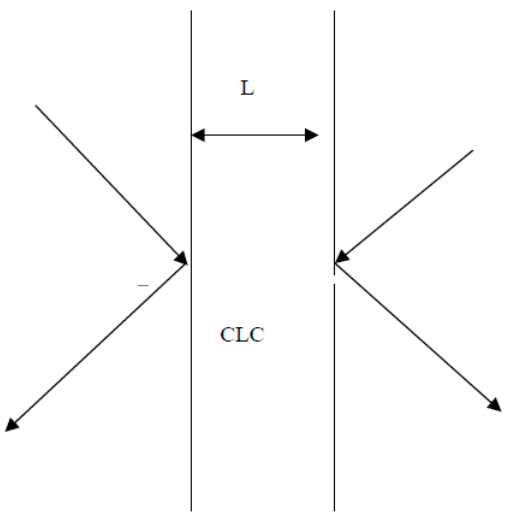
Figure 2. Schematic of the boundary problem for conical edge modes.